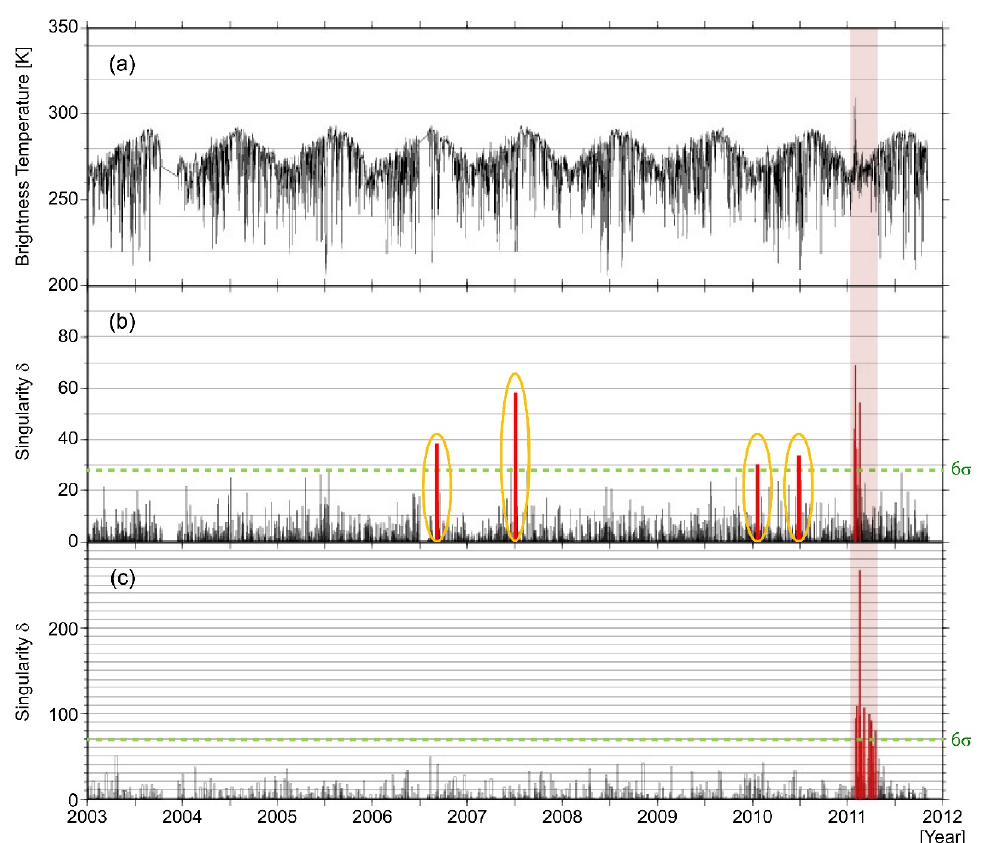
Figure 8. Temporal variation of brightness temperature and singularity at the summit crater of Shinmoedake from 1 January 2003 to 31 December 2011 in UT. ( a ) Brightness temperature of band 20 (raw data); ( b ) singularity with the Noguchi method for cloud discrimination; ( c ) singularity with this study for cloud detection. Green lines in ( b , c ) represent the threshold for the anomaly in singularity defined by average + 6 σ . Red vertical bars show the day when the singularity exceeds the threshold. The period with pink color is the period of a volcanically active period. Yellow ellipses are false changes due to errors in cloud detection.